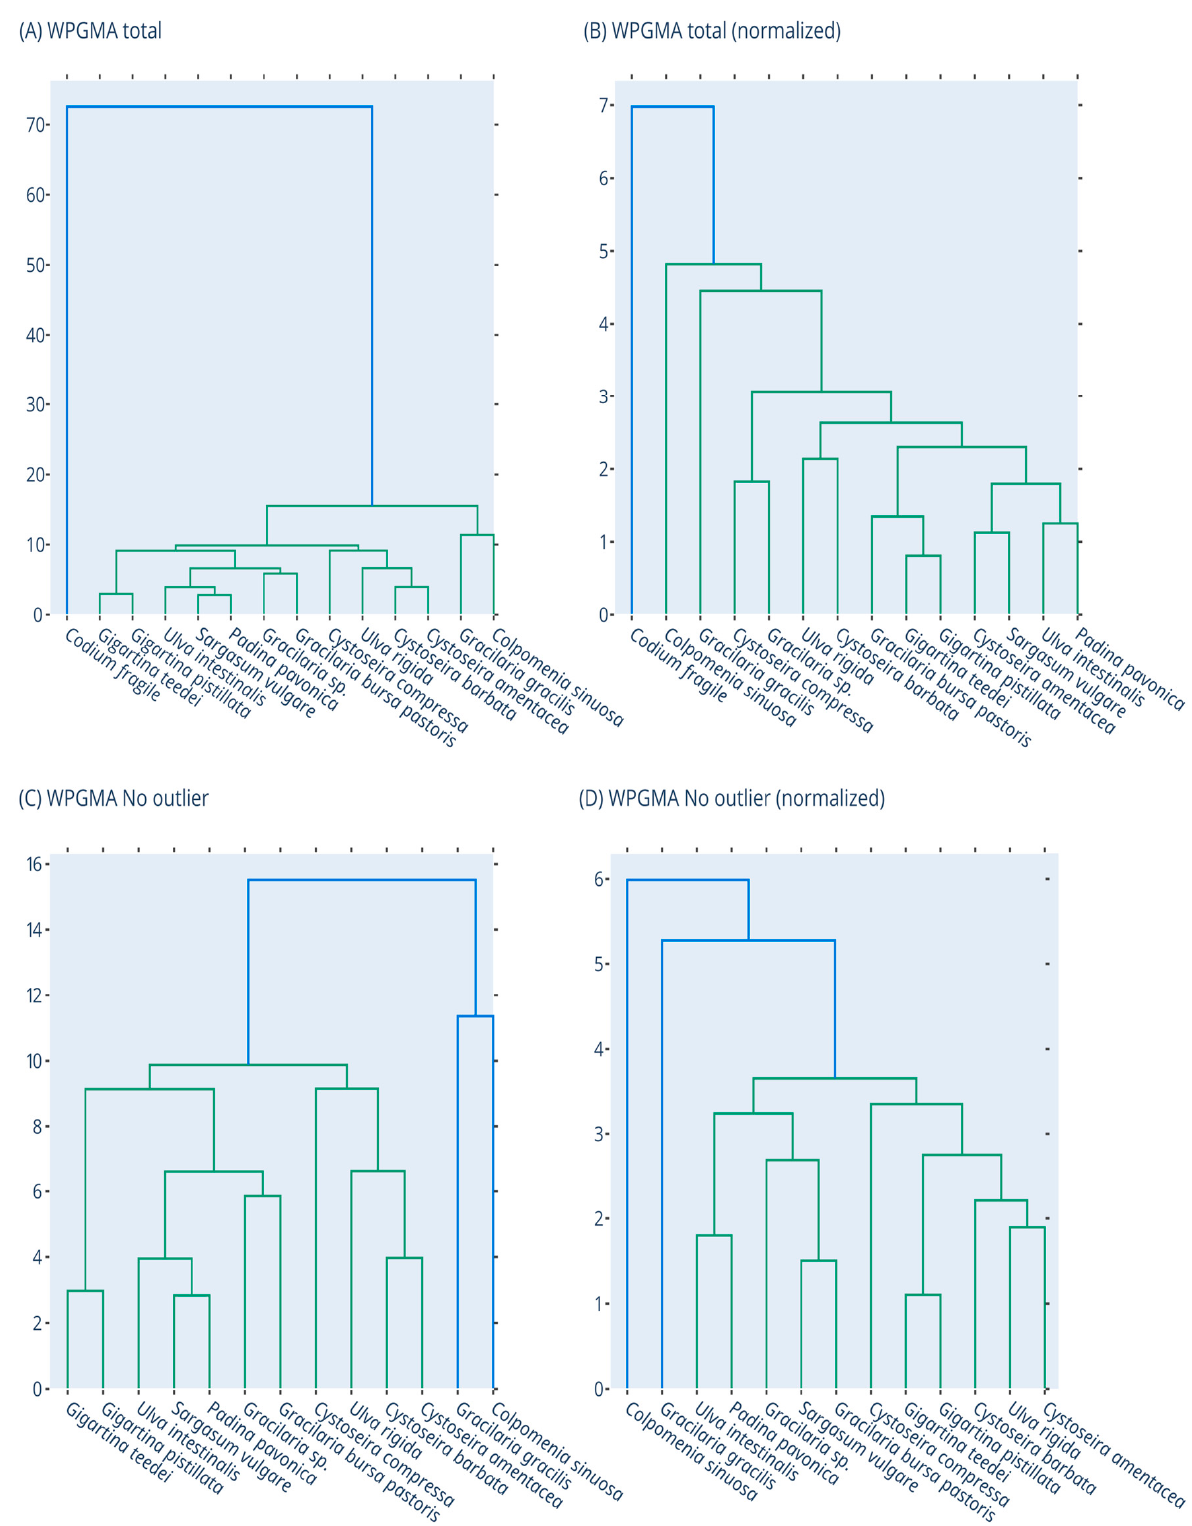
Figure 7. Dendrograms of the samples based on the measurements (raw and normalized) of 7 bioactivity metrics. All dendrograms were created using the WPGMA algorithm and the Euclidian distance. ( A ) Dendrogram of all the 14 samples based on raw measurements. ( B ) Dendrogram of the 14 samples after Z-score normalization. ( C ) Dendrogram of the 13 samples based on raw measurements after removing the outlier ( C. fragile ). ( D ) Dendrogram of the Z-score normalized data after removing the outlier ( C. fragile ).